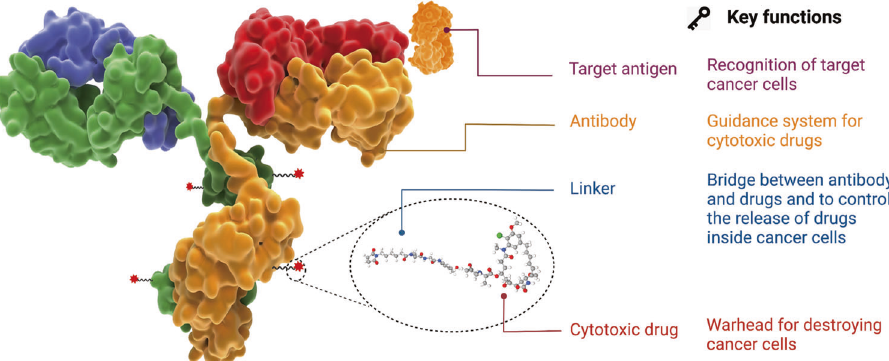
Fig. 2 The structure and characteristic of an ADC drug. The core components including target antigen, antibody, linker, cytotoxic drug along with their key functions are